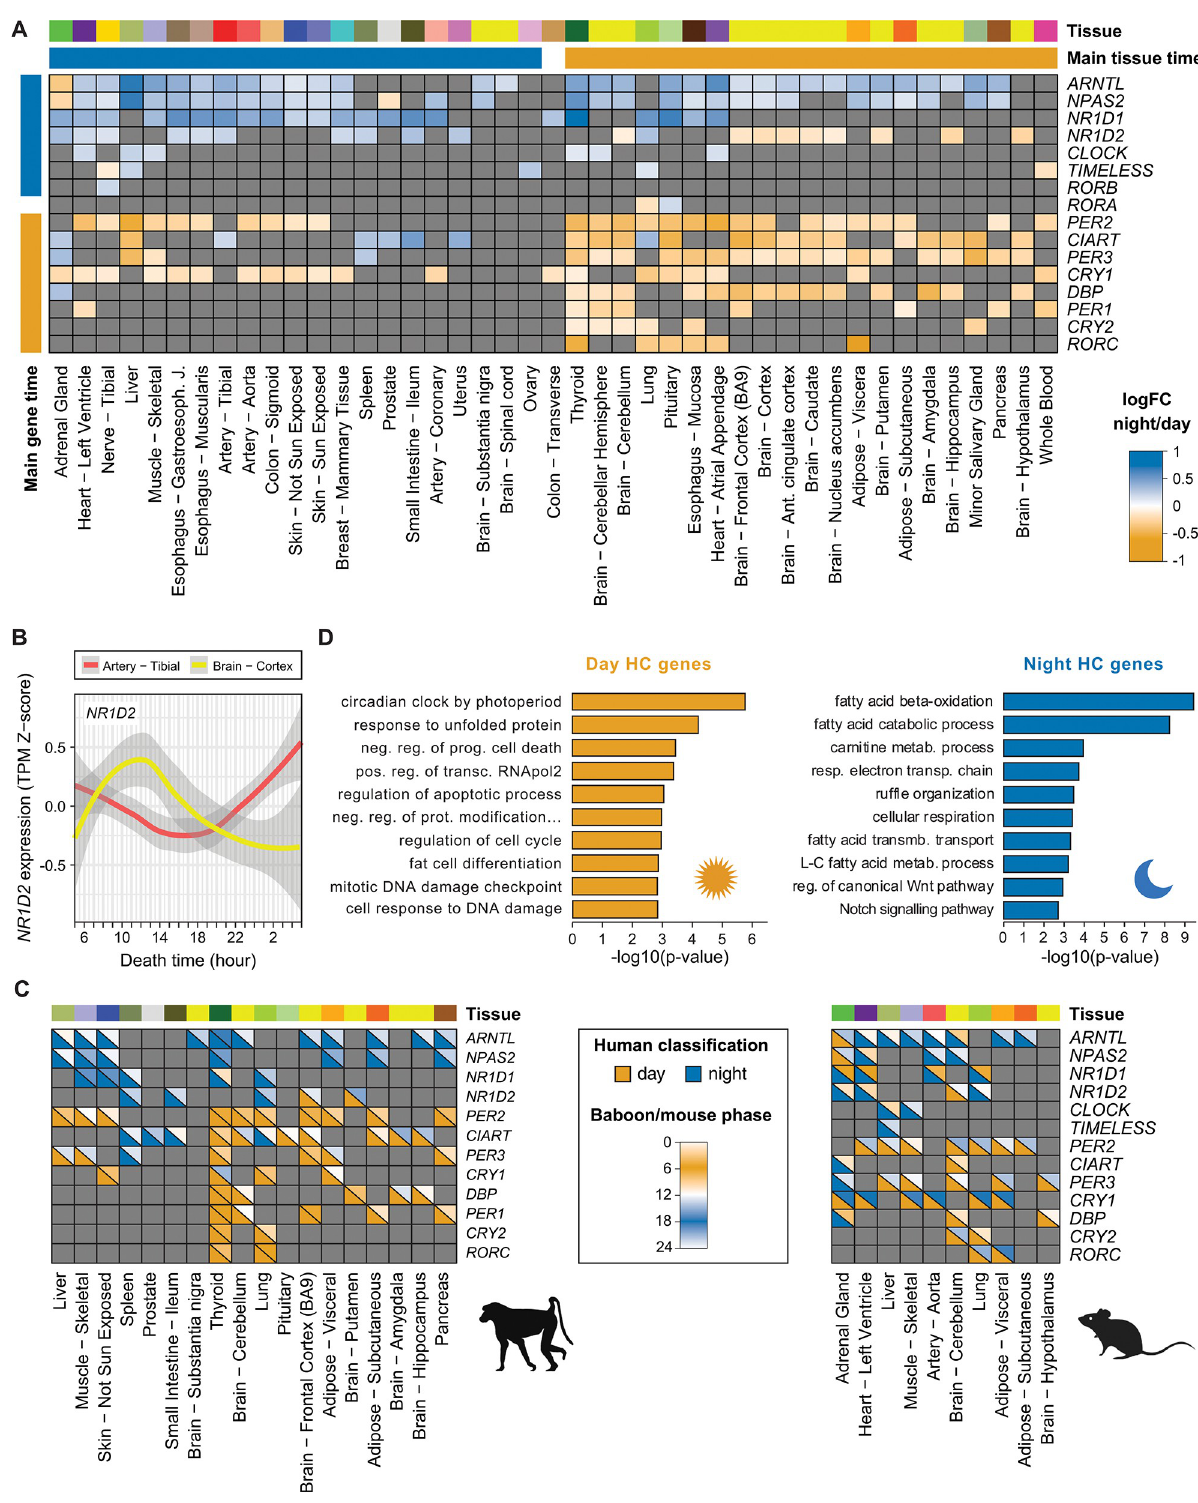
PLOS Biology | https://doi.org/10.1371/journal.pbio.3001986 February 6,